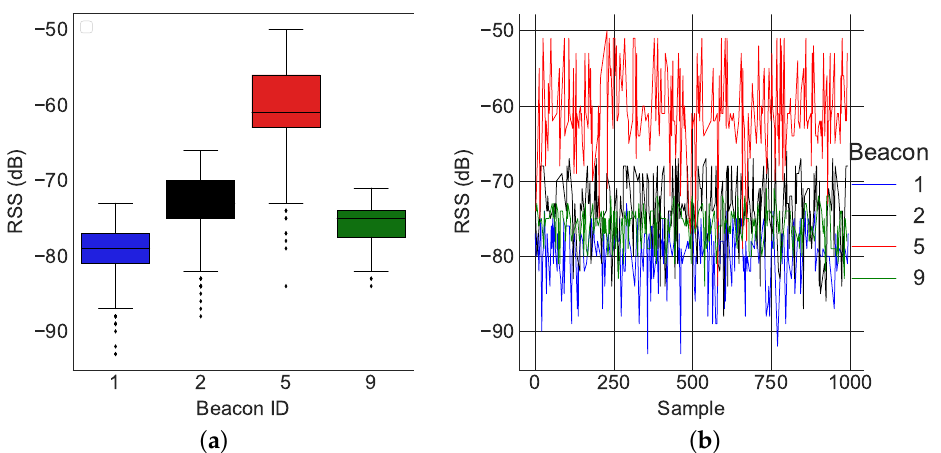
Figure 13. RSS at Reference point 1. ( a ) Distributions of RSS for different beacons; ( b ) RSS versus sample number (samples are taken at 4 Hz).